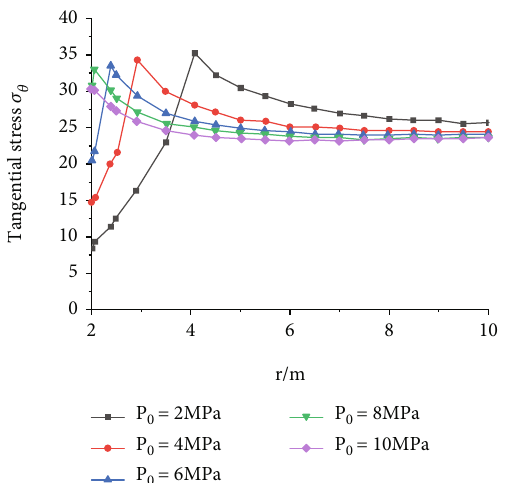
Figure 8: Tangential stress distribution of surrounding rock corresponding to di ff erent P 0 (considering seepage and softening, B = 0 ).